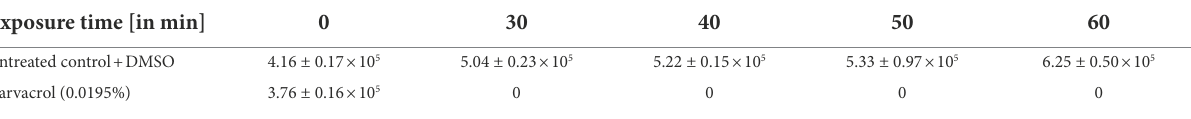
TABLE 6 Number of living bacterial cells in 1 h period from the exposition of Xanthomonas campestris pv. campestris NCPPB 528 T to the 0.0195% carvacrol solution [CFU mL − 1 ]. Exposure time [in min]